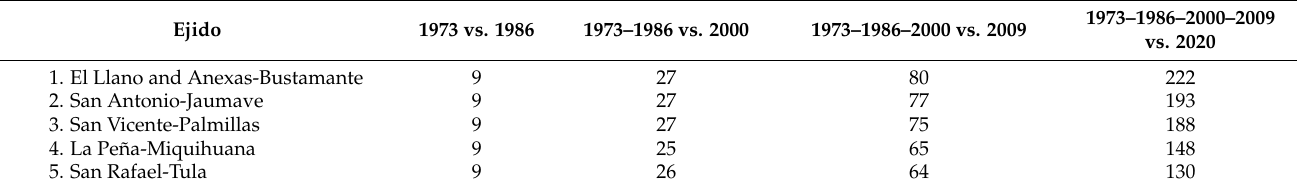
Table 3. The number of categories resulting from the “transition image” for each Ejido of the Tamaulipan Highlands, Tamaulipas,